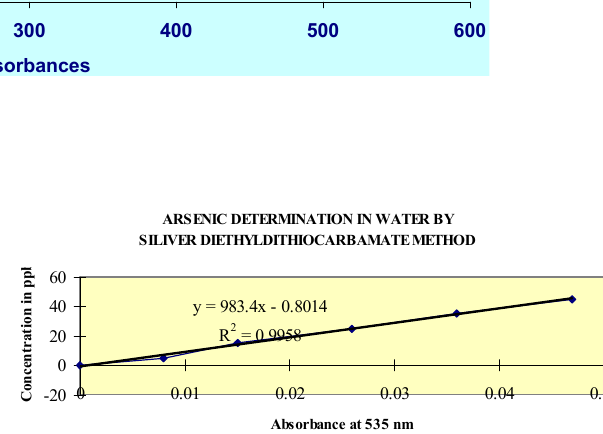
Figure-5: Absorbance Vs. Concentration with Straight Line Figure 5. Absorbance vs. concentration with straight